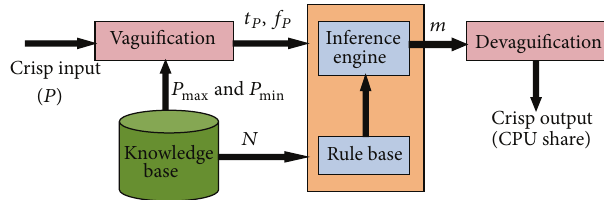
Figure 3: Vague inference system for VMLQ